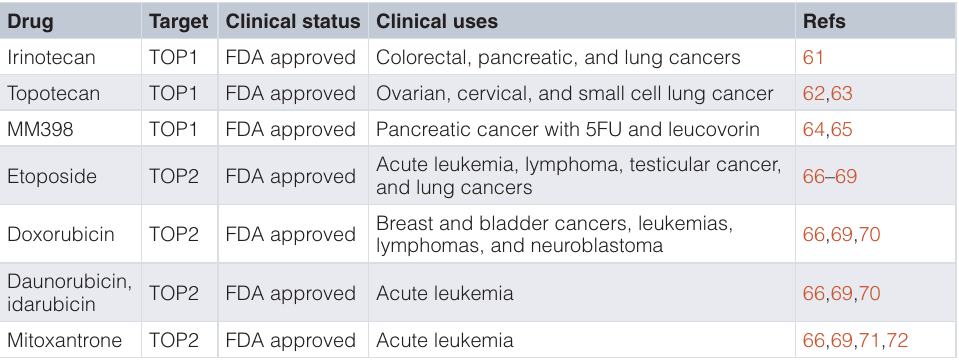
Table 2. FDA-approved anticancer drugs that increase TOP1- or TOP2-containing